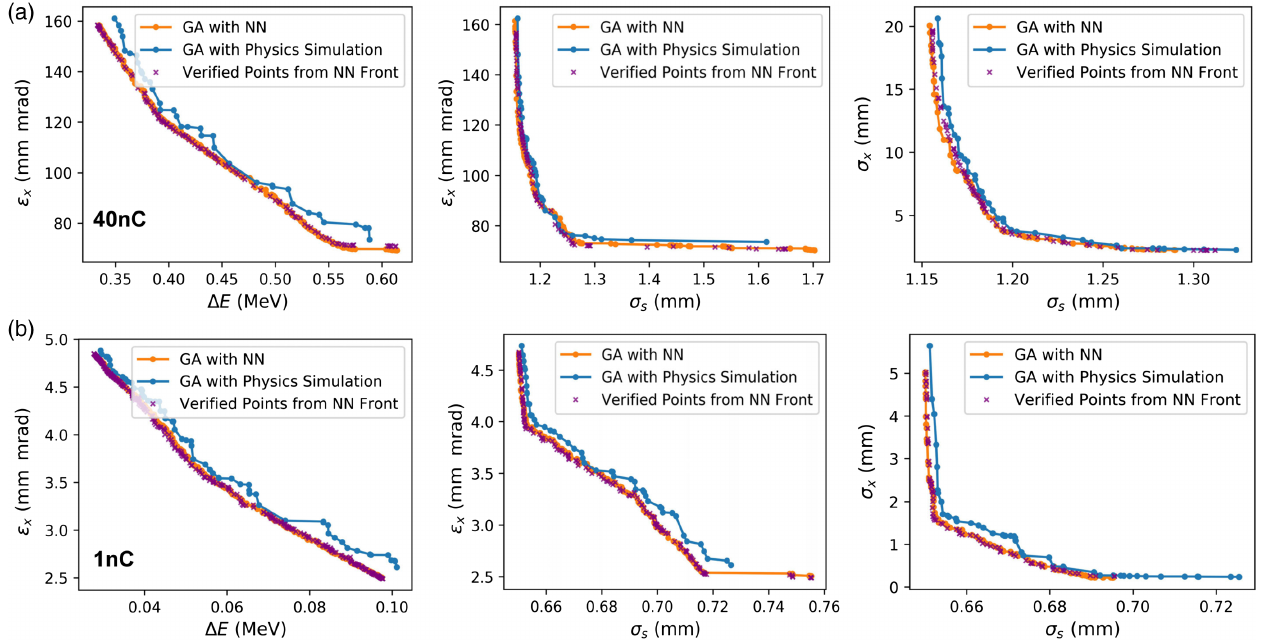
FIG. 4. Comparison between estimated Pareto fronts obtained from the NN and the physics simulation for three sets of beam parameters. We show results at the 40 nC bunch charge (a) and at the 1 nC bunch charge (b) configurations, and we find excellent agreement between the estimated Pareto fronts. In total seven beam parameters have been optimized, and we show the 2D projections from this larger front for the parameters that are most critical for optimization of the AWA. The other projections show similar